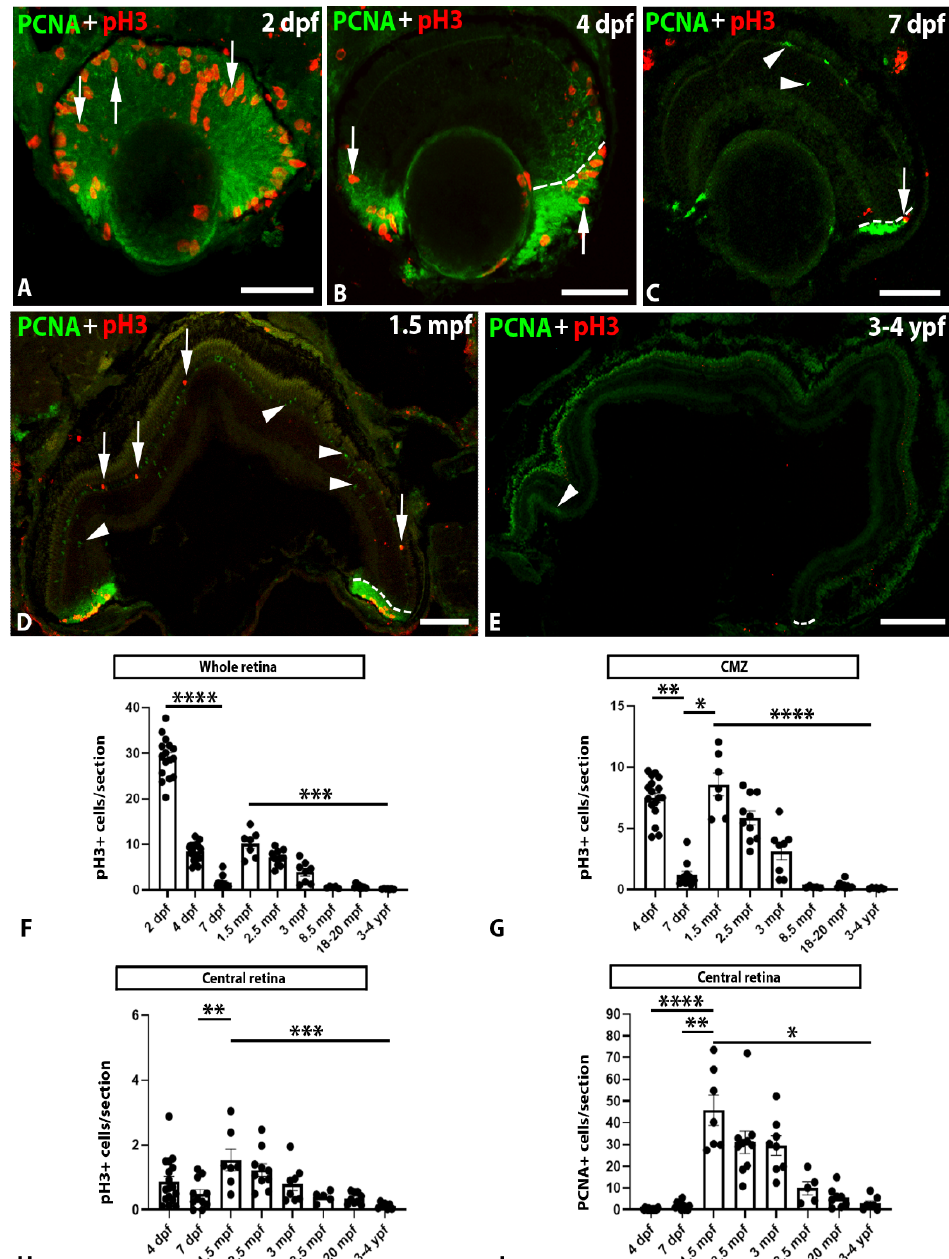
Figure 2. ( A – E ). Transverse sections of the retina of 2 dpf ( A ), 4 dpf ( B ), 7 dpf ( C ), 1.5 mpf ( D ), and 3–4 ypf ( E ) zebrafish specimens showing the presence of PCNA (arrowheads) or pH3 (arrows) positive cells. In 2 dpf to 1.5 mpf zebrafish ( A – D ), PCNA or pH3 expressing cells were mainly located in the CMZ but also in the central retina, while, in 3–4 ypf, specimens ( E ) pH3+ and PCNA+ cells almost disappeared. Dashed lines in ( B – E) indicate the limit between the CMZ and the central retina. Scale bars: ( A – C ): 50 µm; ( D ): 100 µm; ( E ): 200 µm. ( F ). Graph showing significant changes in the number of pH3+ cells/section in the whole retina at different ages (Kruskal-Wallis test, p < 0.0001). ( G ). Graph showing significant changes in the number of pH3+ cells/section in the CMZ at different ages (Kruskal-Wallis test, p < 0.0001). ( H ). Graph showing significant changes in the number of pH3+ cells/section in the central retina at different ages (one-way ANOVA, p < 0.0001). ( I ). Graph showing significant changes in the number of PCNA+ cells/section in the central retina at different ages (Kruskal-Wallis test, p < 0.0001). Mean ± S.E.M. data and data on statistical multiple comparisons related to these graphs can be found on File S1. Asterisks indicate different levels of statistical significance: *, p < 0.05; **, p < 0.01; ***, p < 0.001; ****, p < 0.0001.